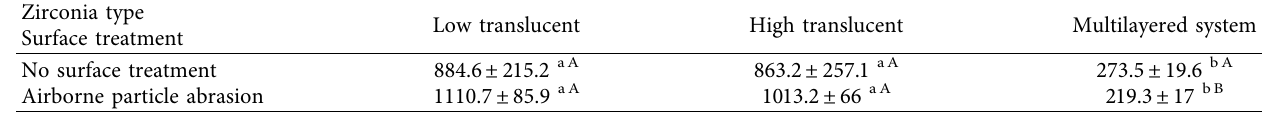
Table 1: Mean ± standard deviation of flexural strength of the three zirconia types (MPa) ( P ≤ 0.05).